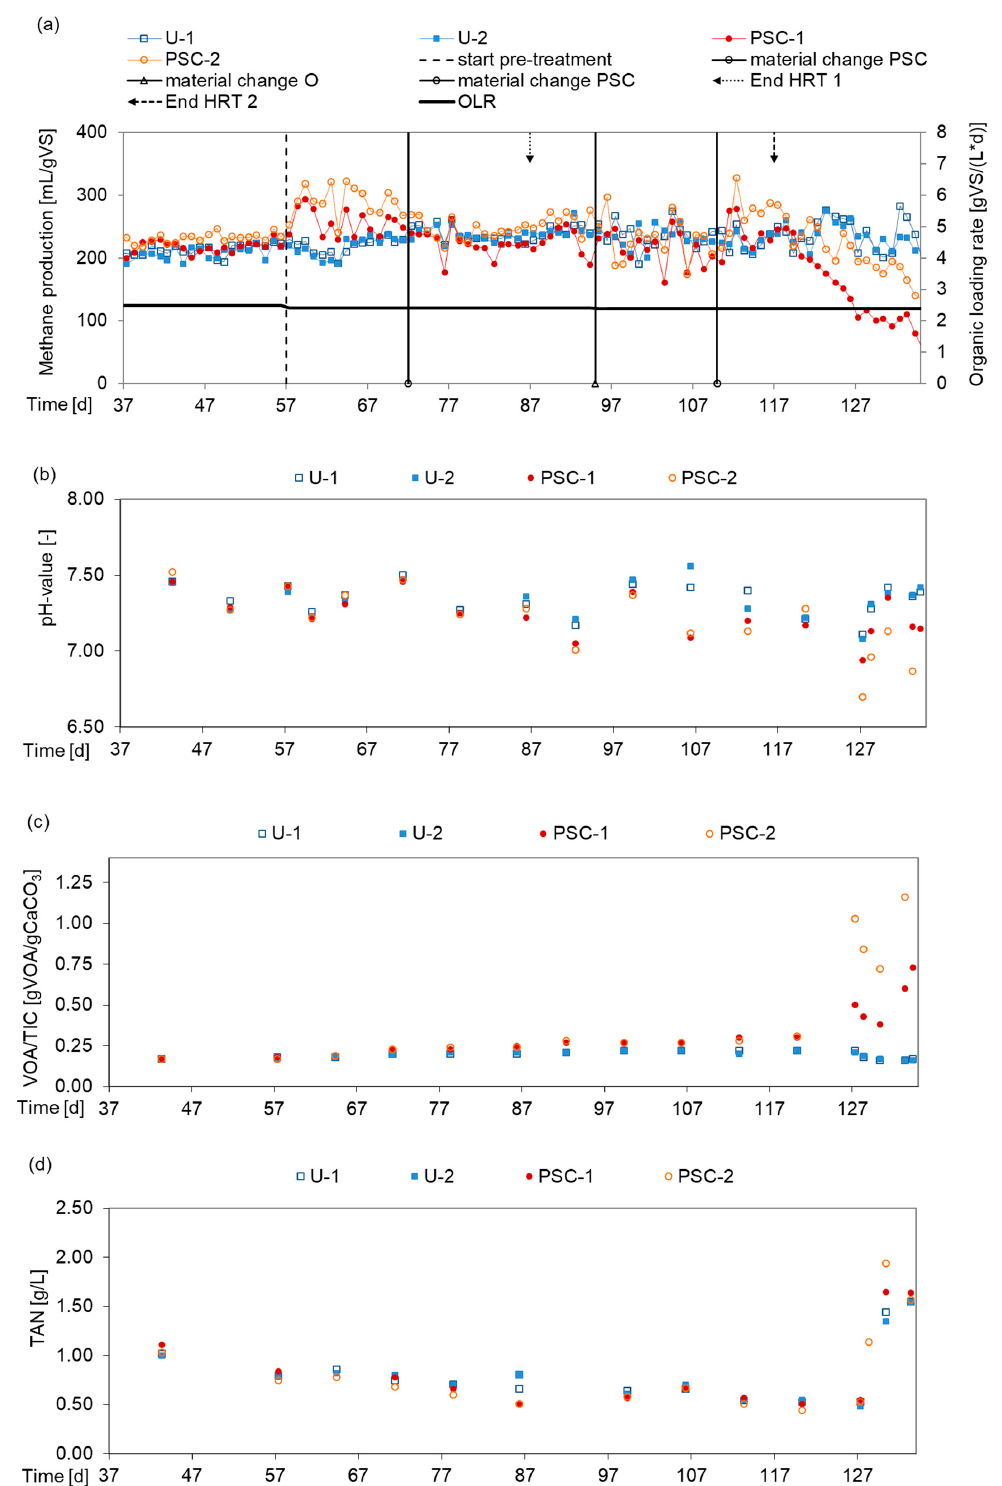
Figure 3. ( a ) Methane production of cattle manure in semi-continuously stirred tank reactor (CSTR) (U = untreated, PSC = pressure swing conditioning); ( b ) pH-value; ( c ) volatile organic acids and total inorganic carbon (VOA/TIC); ( d ) total ammonia nitrogen (TAN).